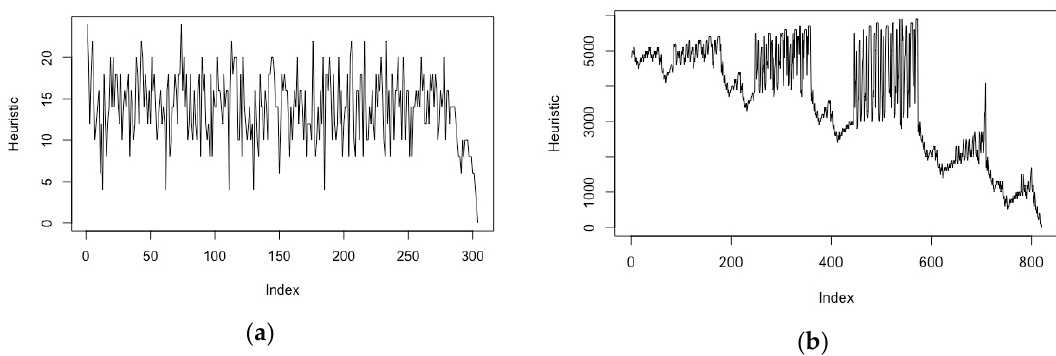
Figure 3. The variation of the heuristic function throughout the search process conditions the type of intervention ( a ) For the 8-puzzle problem, the heuristic function (Manhattan distance for misplaced tiles) oscillates significantly with search backtracking; ( b ) For a path planning problem, such as the one used in our preliminary experiments, there is an overall trend for the heuristic function (straight-line distance in arbitrary grid units) as the path progresses towards the goal node.